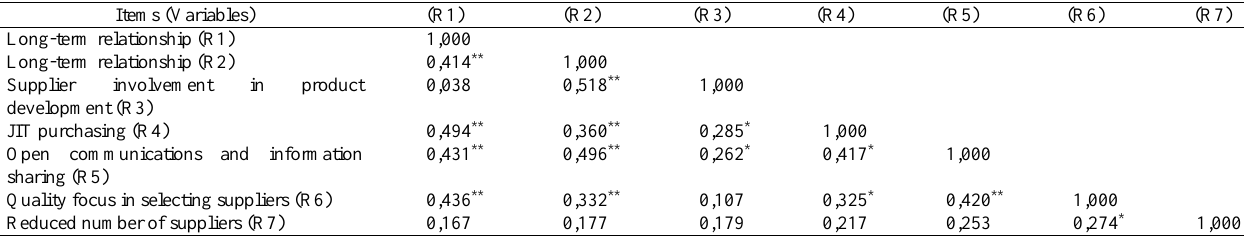
Table 1: Correlation among buyer-supplier relationships Items (Variables)